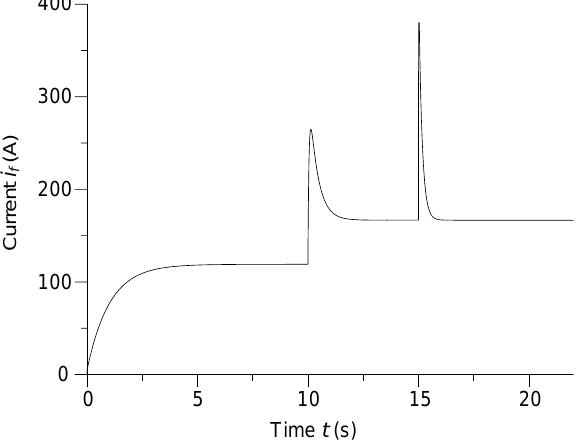
Figure 7. The instantaneous current in the excitation winding of the shaft generator rotor. The value of the excitation current was lowered to a value that allowed the generator armature voltage to stabilize at the rated voltage level (see Figure 5). At the time of loading, the currents in the armature windings increased, and after approx. 2.5 s, they reached their steady-state rated value. A similar situation occurs in the case of the shaft generator excitation current.